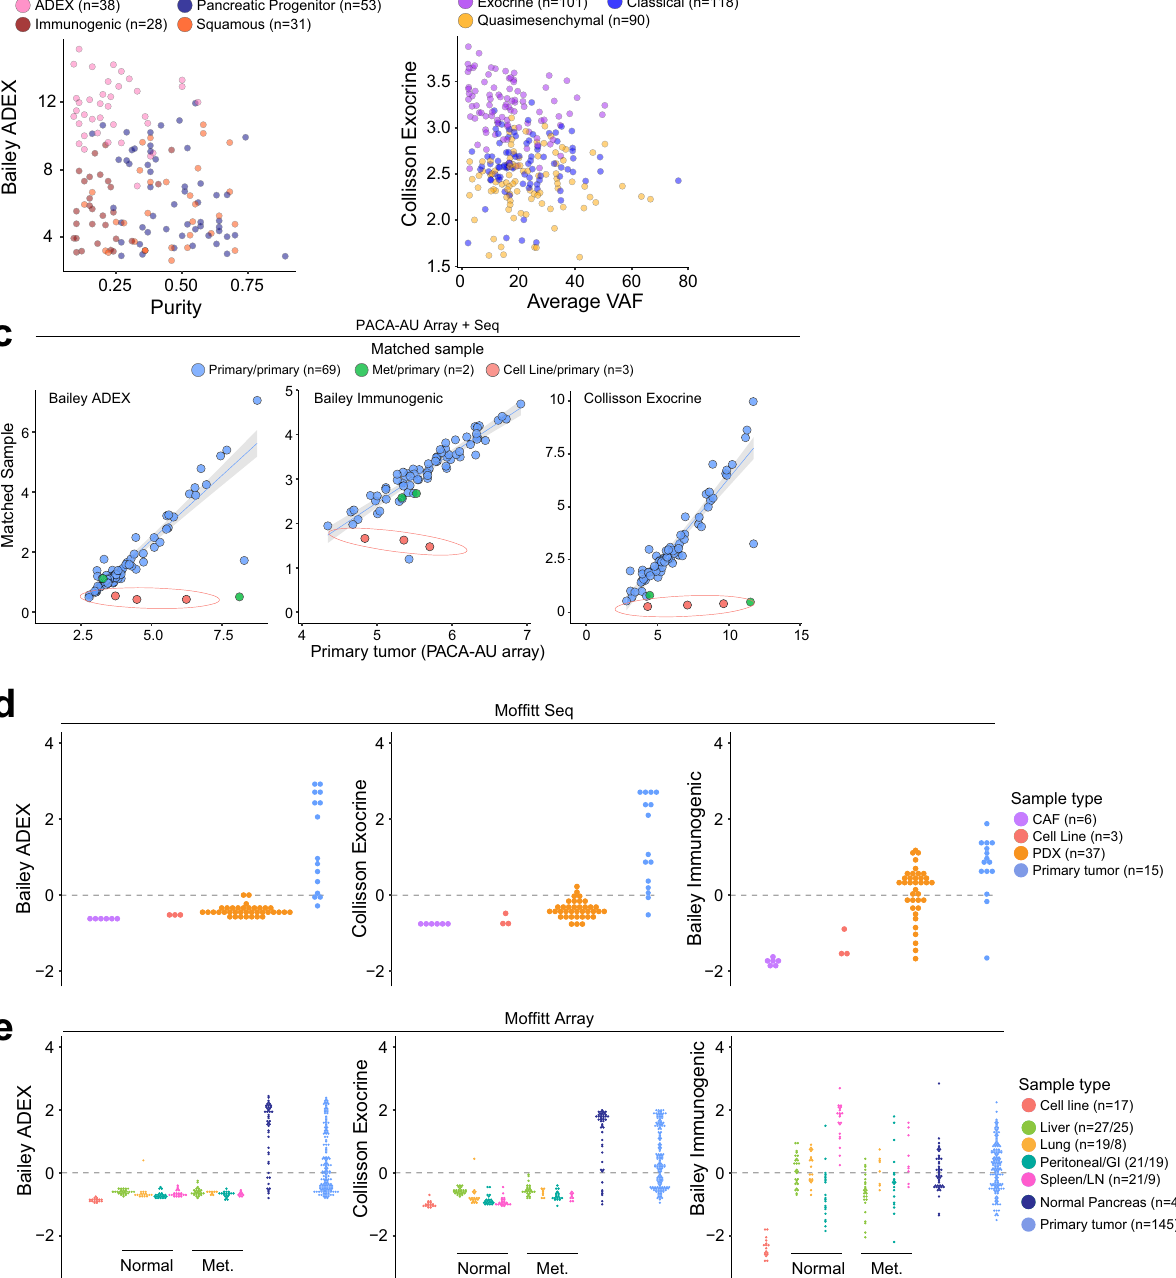
Met. Met. Fig. 2 ADEX, Exocrine, and Immunogenic PDAC subtypes are not tumor-intrinsic. a Expression of genes in the Bailey ADEX geneset is inversely correlated with tumor sample purity, assessed by ABSOLUTE, in the TCGA dataset (Spearman rho = − 0.260, p = 0.0014, n = 150). Low tumor sample purity is predictive of high ADEX geneset expression. b The Collisson exocrine geneset exhibits the pattern seen in the TCGA dataset ( a ), extended to the Puleo microarray (Spearman rho = − 0.221, p = 0.0003, n = 309). c Matched samples between the PACA-AU RNAseq and PACA-AU array datasets show that the ADEX, Collisson Exocrine, and Bailey Immunogenic gene signatures are lost in cell lines and metastatic tumors derived from primary PDAC tumors expressing either high or low levels of the same gene signatures (gene expression plotted as the average of the log2 transformation of the genes which de fi ne the subtype). d The ADEX and Exocrine genesets are highly expressed in primary tumor samples compared to cancer-associated fi broblasts (CAFs), cell lines, and patient-derived xenografts (PDXs), though the Bailey Immunogenic geneset demonstrates appreciable expression in PDXs. e ADEX and Exocrine gene signatures are highly expressed in normal pancreas or primary PDAC tumors, and are comparatively absent from metastatic tumors, cell lines, and normal non-pancreas samples, whereas the Immunogenic gene signature is expressed across normal non-pancreas, metastatic, normal pancreas, and primary PDAC tumors but is lost in cell lines. Y-axes from ( d ) and ( e ) represent the mean-centered, scaled average expression for the indicated